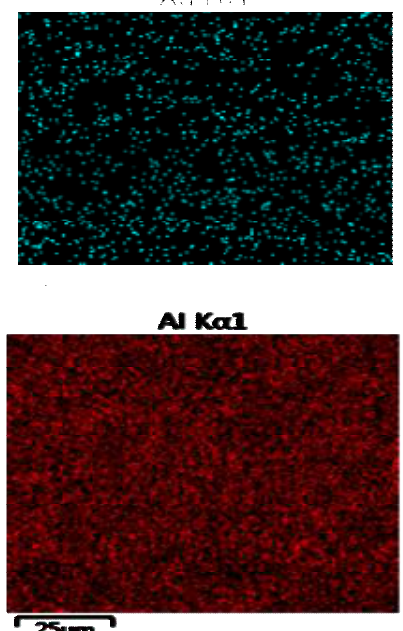
Figure5: SEM/EDX Mapping of Ag + and Al +3 B-In vitro Part of Study Mechanical testing Descriptive statistics of removal torque values fig 4 .